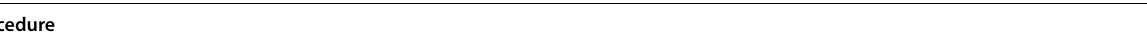
Table 2 Study: Are Vaccination Perceived as Human